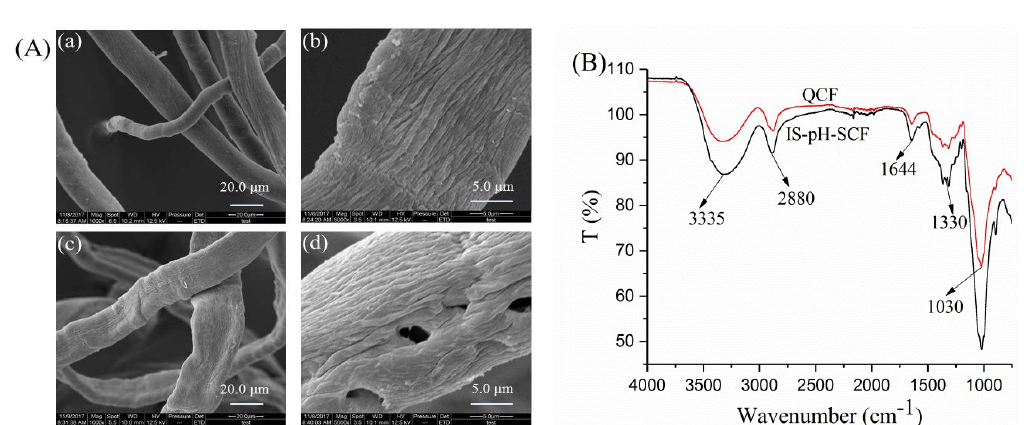
Figure 6. ( A ) SEM of QCF (( a ) ×1000, ( b ) ×5000)) and IS-pH-SCF (( c ) ×1000, ( d ) ×5000); ( B ) FTIR spectra of QCF and IS-pH-SCF.